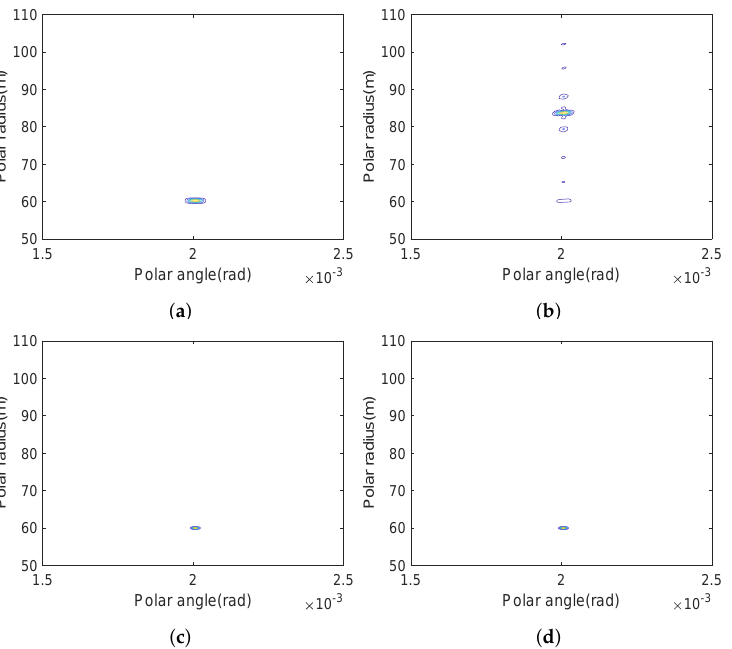
Figure 10. Image scene composed of 1 point at [60m,0.002rad](dB): ( a ) FSK-Costas SAR without ISRJ; ( b ) FSK-Costas SAR with ISRJ; ( c ) RSF-DC-DFC SAR without ISRJ; ( d ) RSF-DC-DFC SAR with